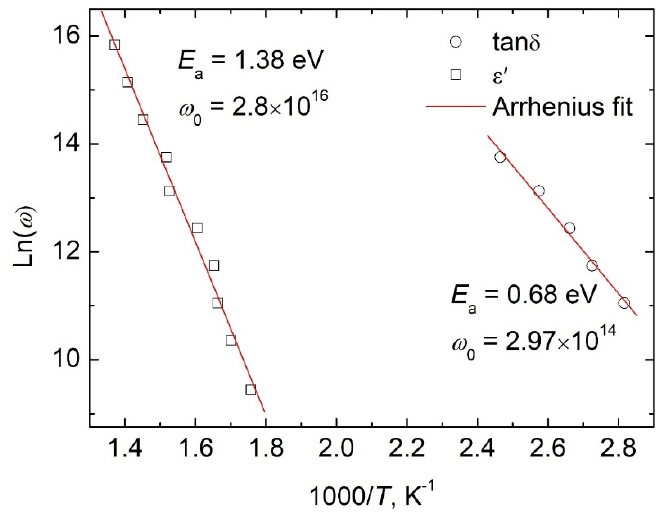
Figure 2. Arrhenius plots describing relaxation processes on ε ′ / ε 0 ( T ) and tan δ ( T ) dependences of BiFeO 3 ceramics.